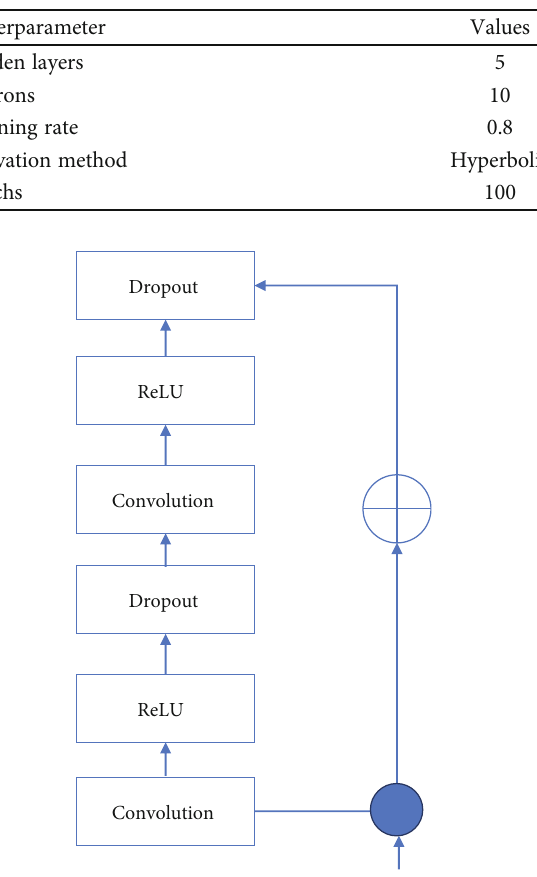
Figure 4: Residual block.